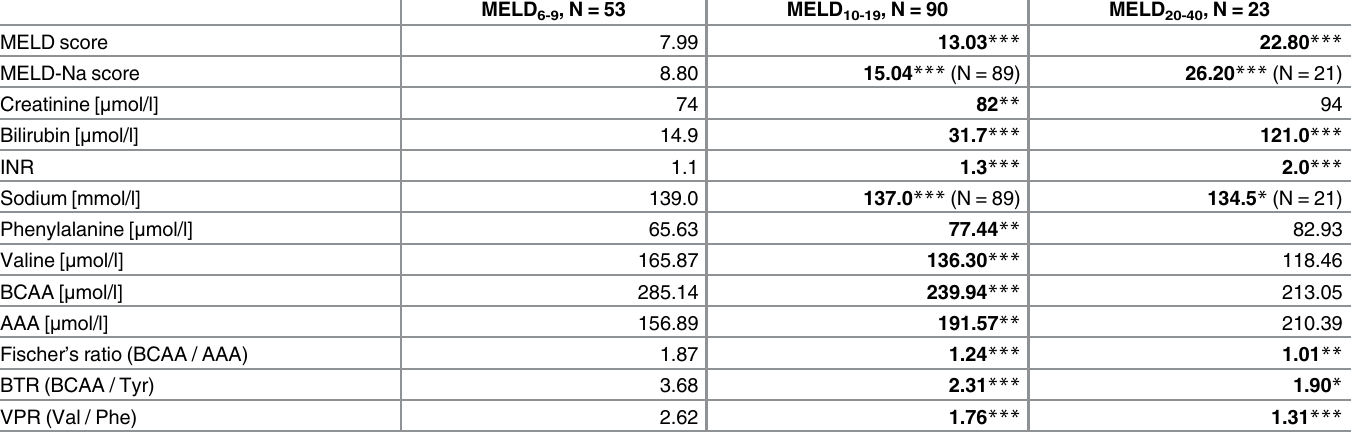
Table 5. Description of the analyzed cohort divided in three groups according to MELD score ranges 6 to 9, 10 to 19 and 20 to 40. Values in the table are medians. Distributions in group MELD 6-9 compared to MELD 10-19 and MELD 10-19 compared to MELD 20-40 were analyzed using Mann-Whitney- U-Test. Significant results are written in bold and asterisked ( * , ** , ***